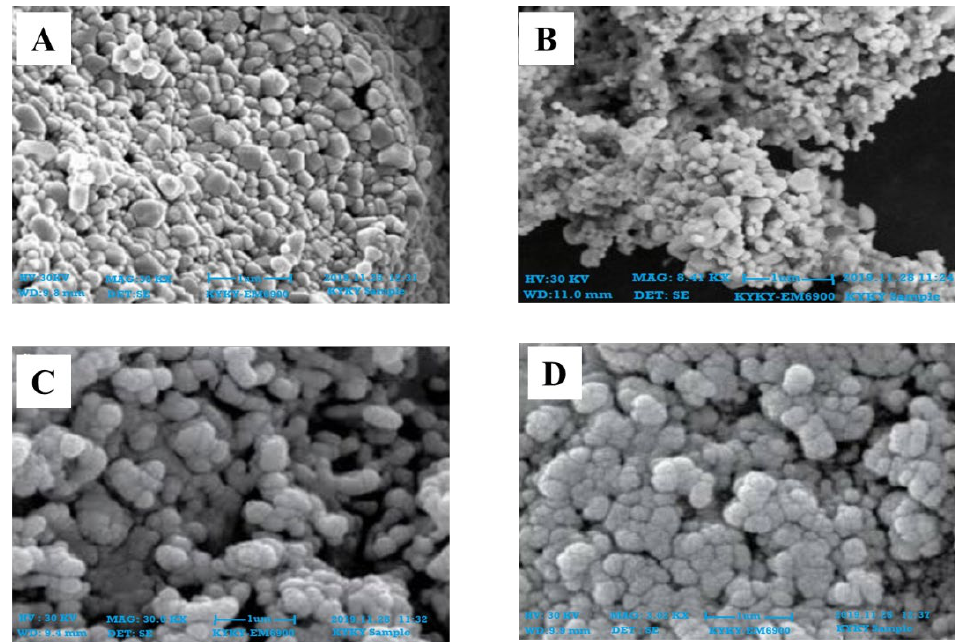
Figure 5. SEM images of zinc oxide nanoparticles of roots; (A) n_Hexane ( B ) Ethyl Acetate ( C ) Methanol ( D ) Aqueous.